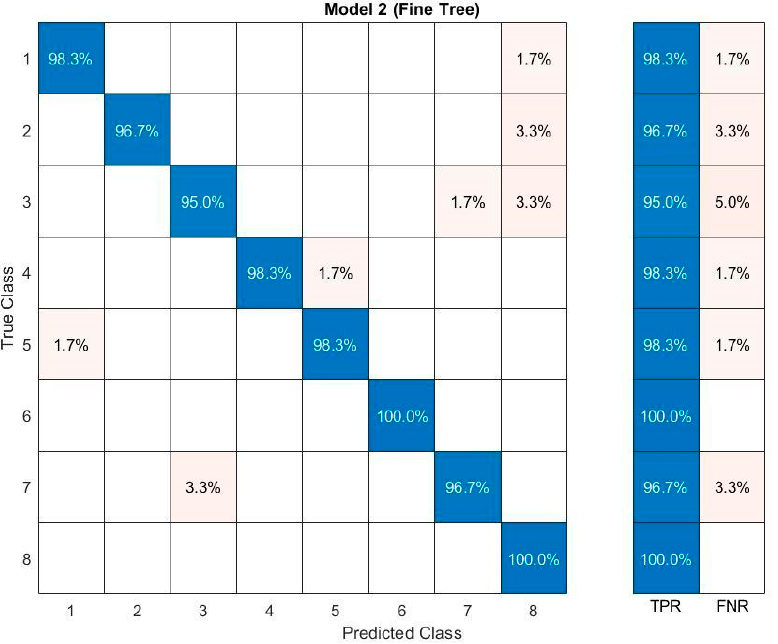
Figure 7. Fine-tree-model confusion